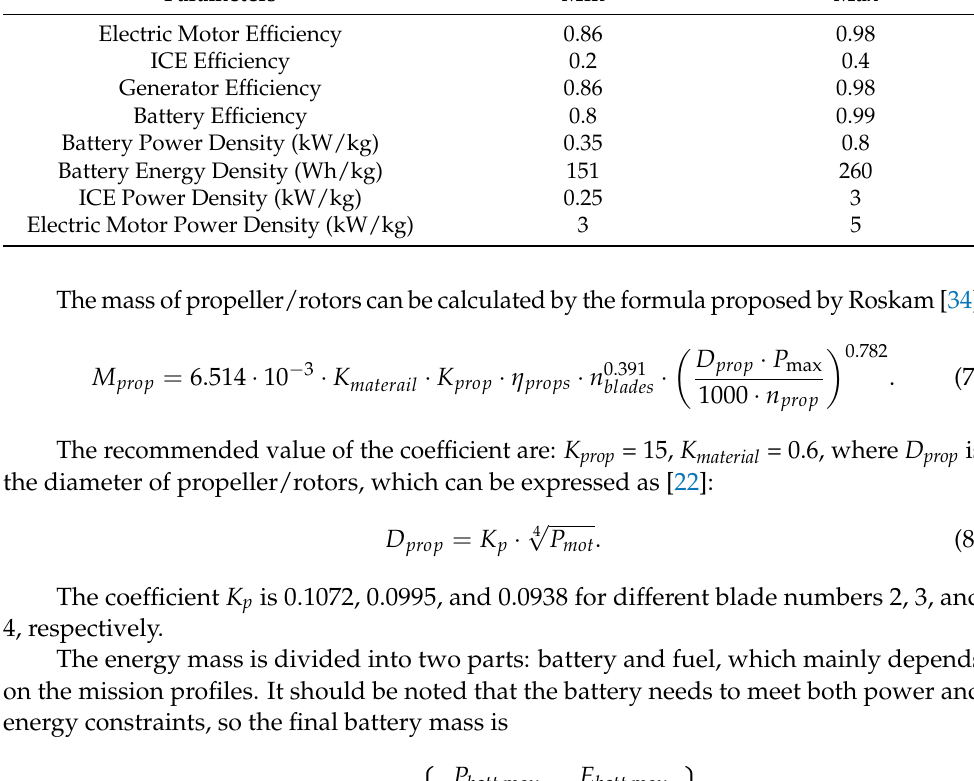
Table 1. Technology assessment of hybrid electric systems. Data from [27]. Parameters Min